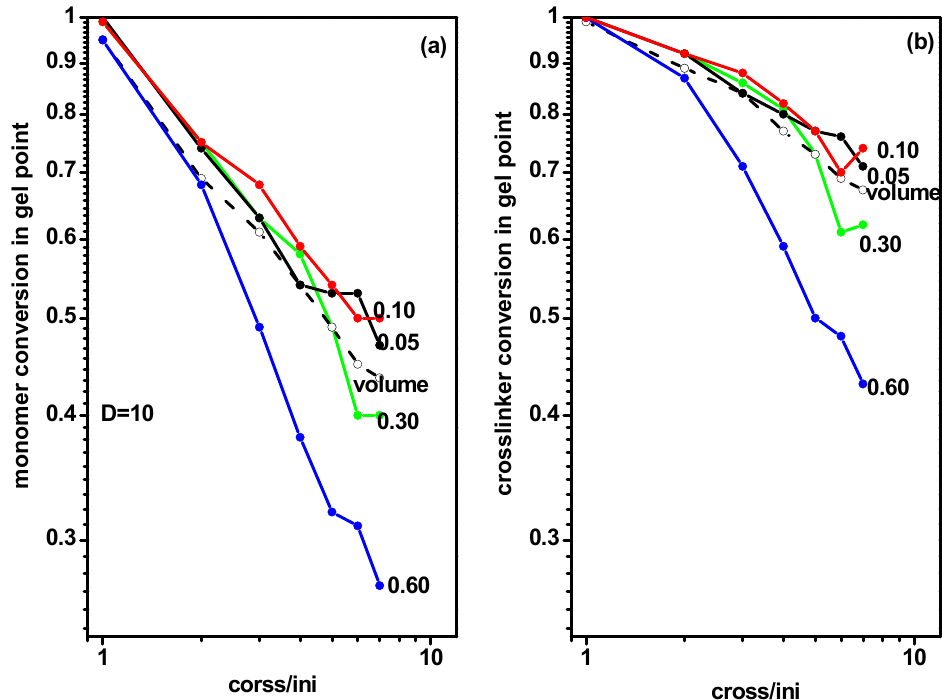
Figure 8. The conversion of monomer ( a ) and cross-linker ( b ) at the gel point during polymerization of grafted chains in a slit, with d = 10 as a function of the ratio [Ini]/[X] for different widths of the slit. The grafting densities are given in the inset. The conversion of monomer and cross-linker at the gel point for a free volume are marked by the dashed line.